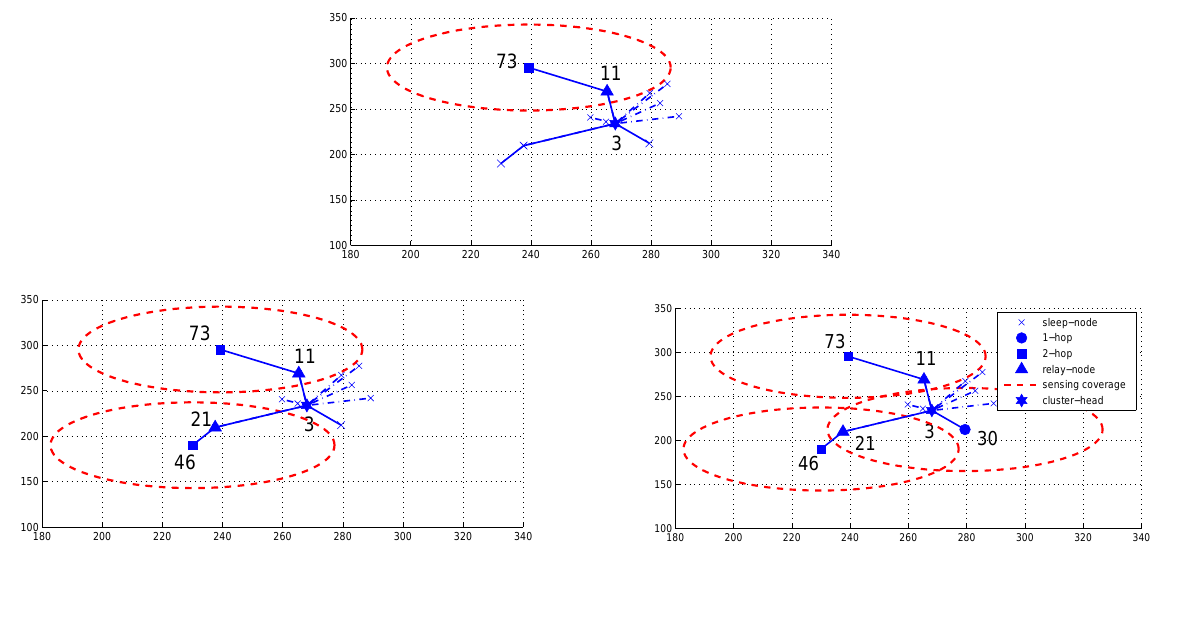
network performance. With varying the number of sensors N rounds N versus α for β = 1 (left) and N RG